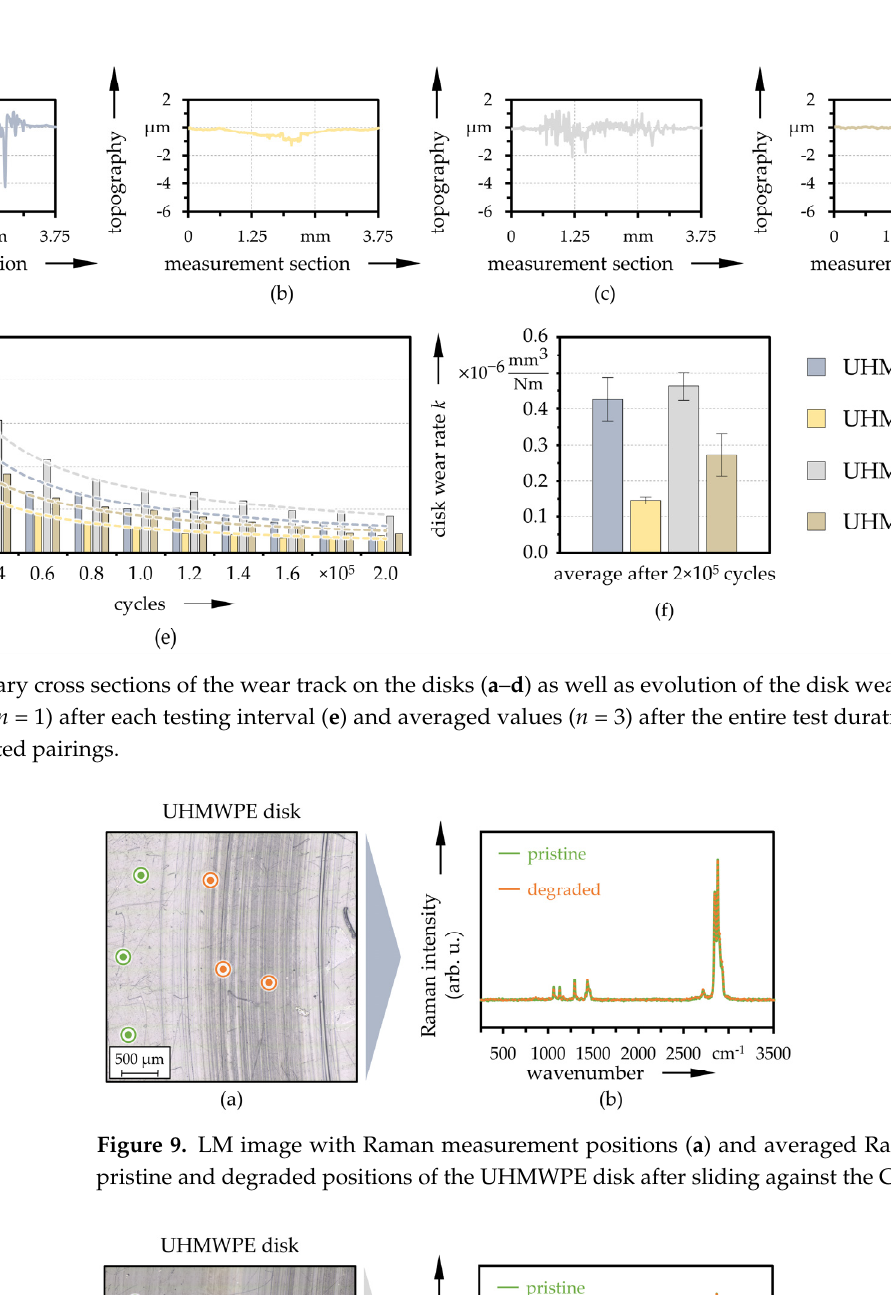
Figure 9. LM image with Raman measurement positions ( a ) and averaged Raman spectra ( b ) at pristine and degraded positions of the UHMWPE disk after sliding against the CoCr pin ( n = 3).